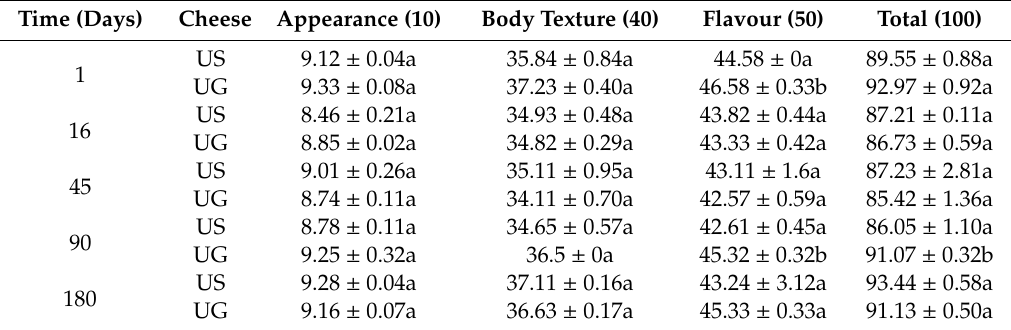
Means of three cheese-making trials ± standard error. Mean values in brackets show the maximum scores. Total (100) is the sum of values of appearance (10), body texture (40) and flavour (50). a, b: means for each parameter in the same column and sampling day with di ff erent letters significantly di ff er ( p < 0.05). Table 4. Changes of organoleptic characteristics of Urda cheese made from 100% sheep (US) or a mixture of 90% sheep–10% goat (UG) whey during ripening and